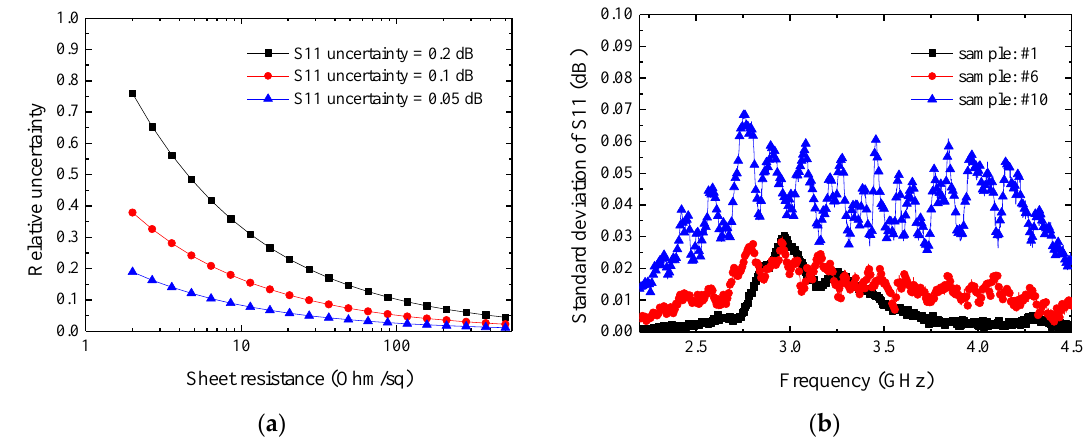
Figure 7. ( a ) Effect of the measurement uncertainty of S 11 on sheet resistance evaluation; ( b ) effect of the horizontal position of samples on measured S 11 .